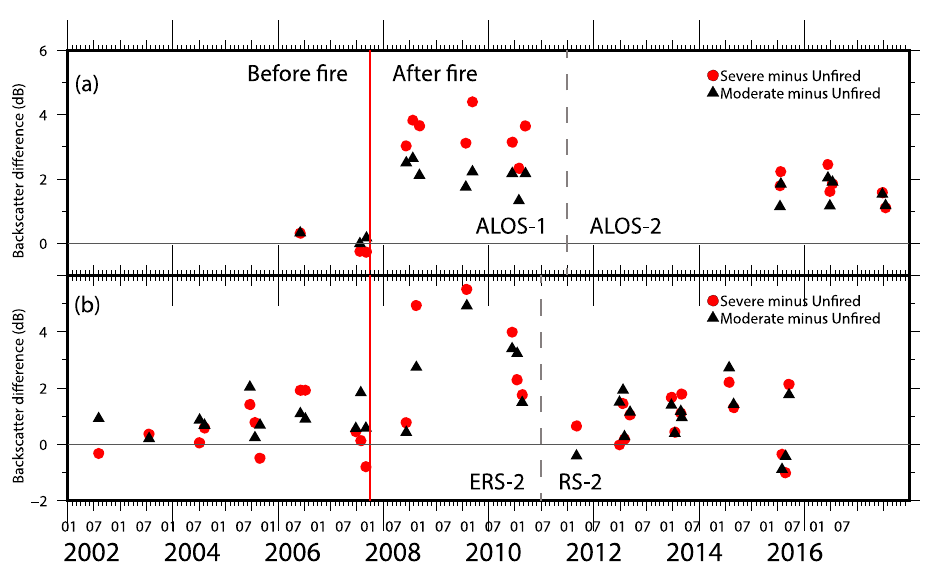
Figure 7. Time series of backscatter difference between burned and unburned sites. ( a ) for ALOS-1 and ALOS-2, ( b ) for ERS-2 and RS-2.